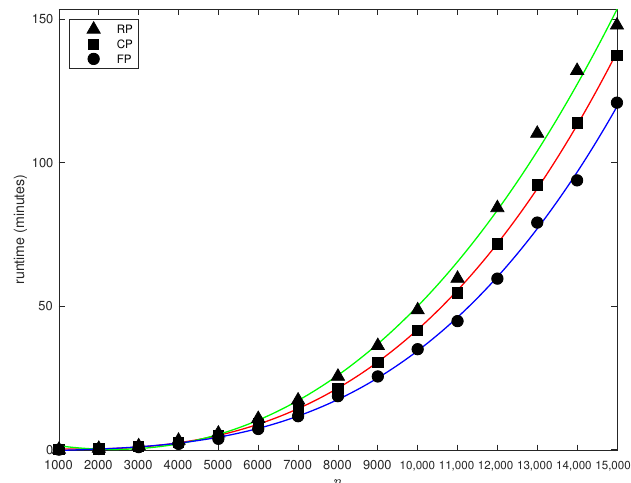
Figure 1. Runtimes of index algorithms vs. number of project states with cubic least-squares